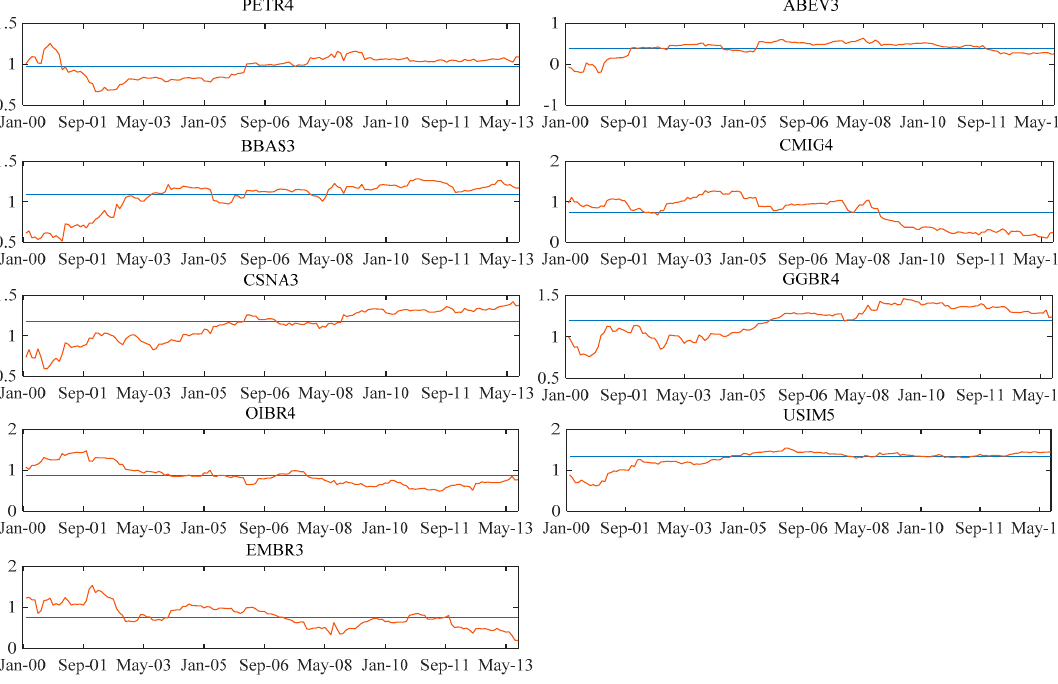
Figure A2. β (red line) versus “ β OLS” (blue line): Random walk model.